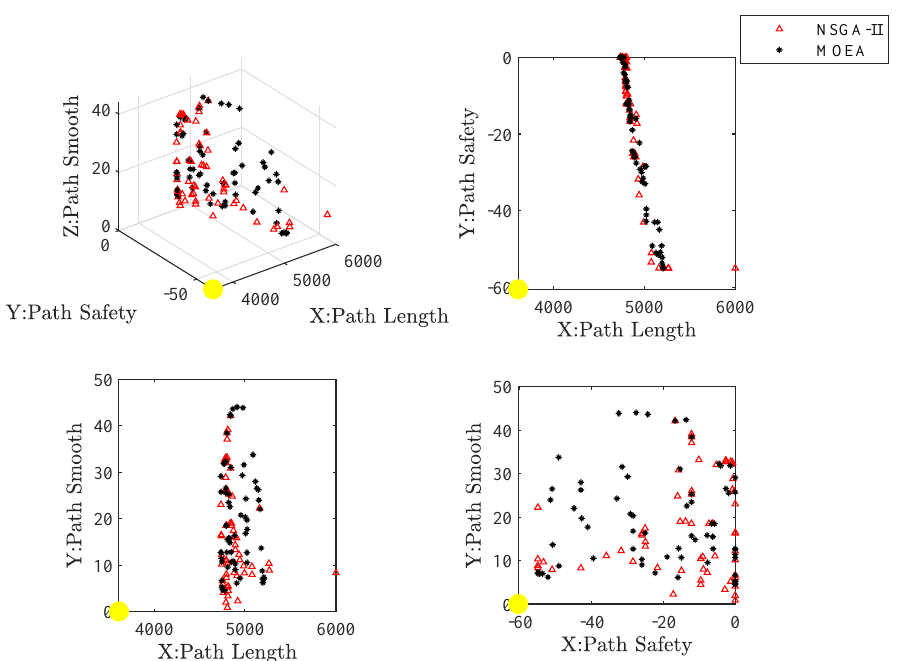
Figure 23. Based on Figure 11A, the approximate Pareto fronts generated by the two algorithms NSGA-II and MOEA. The sub-figure of the upper left corner shows the image of the approximate Pareto front in three-dimensional space. The remaining three sub-figures are the projections of the approximate Pareto front in the two-dimensional space.